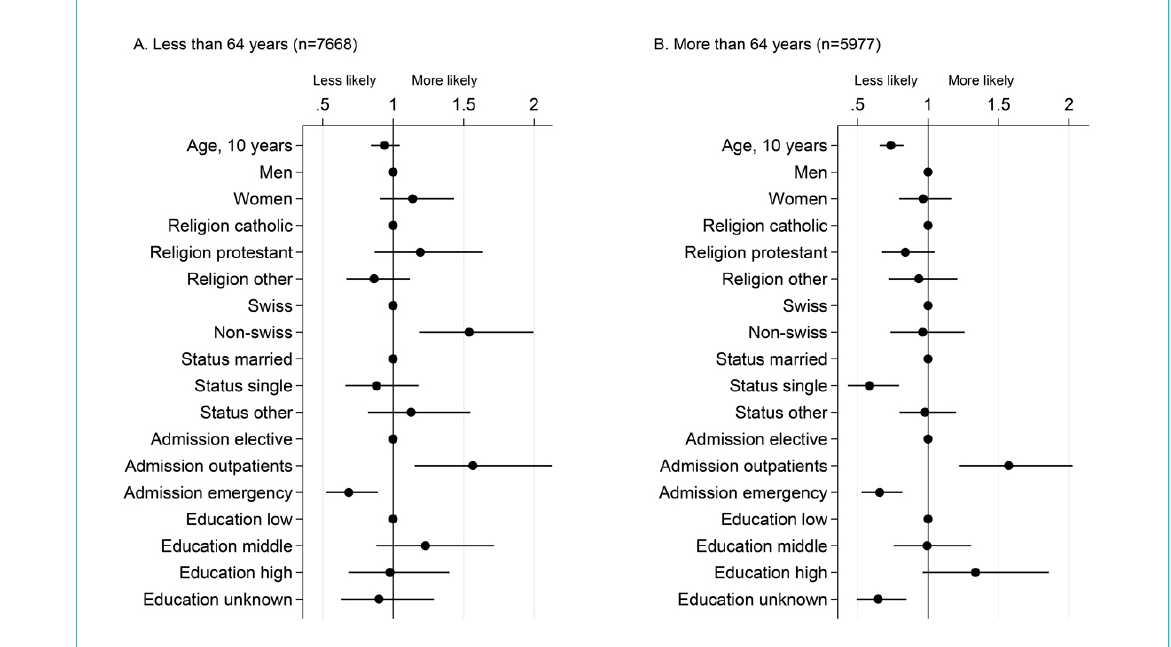
Figure S3: Factors associated with interest in being re-contacted for incidental findings among patients with information available on education level . This analysis is restricted to the 17 518 patients for whom information on education level is available. Dots represent odds ratios and bars 95% confidence intervals from a multivariable logistic model including willingness to receive incidental findings, among patients having accepted to participate, as the dependent variable, run separately in the two age